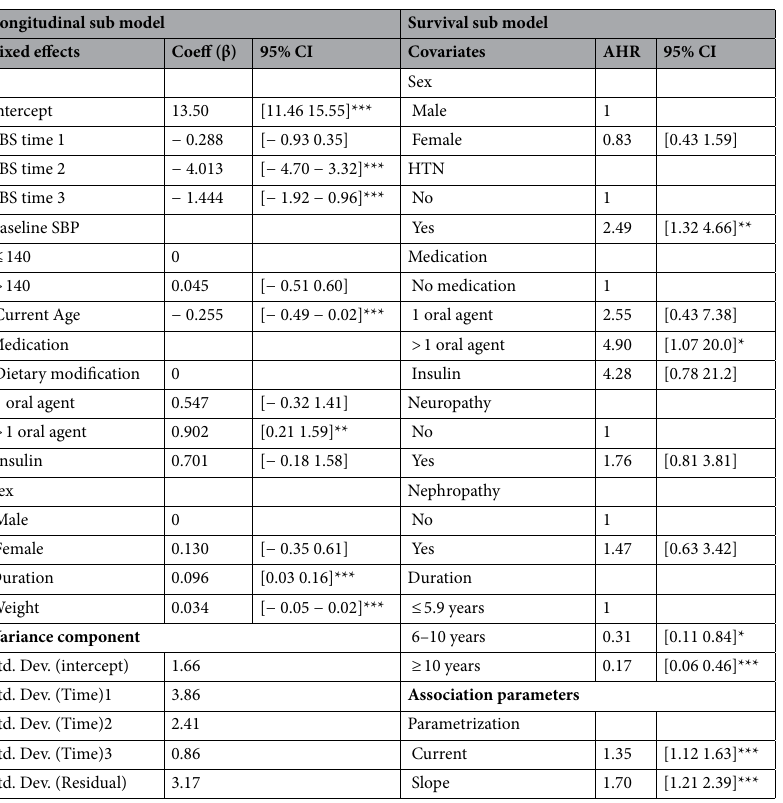
Table 3. The fitted joint model result under current parameterizations for type 2 diabetes patients in UGCSH,